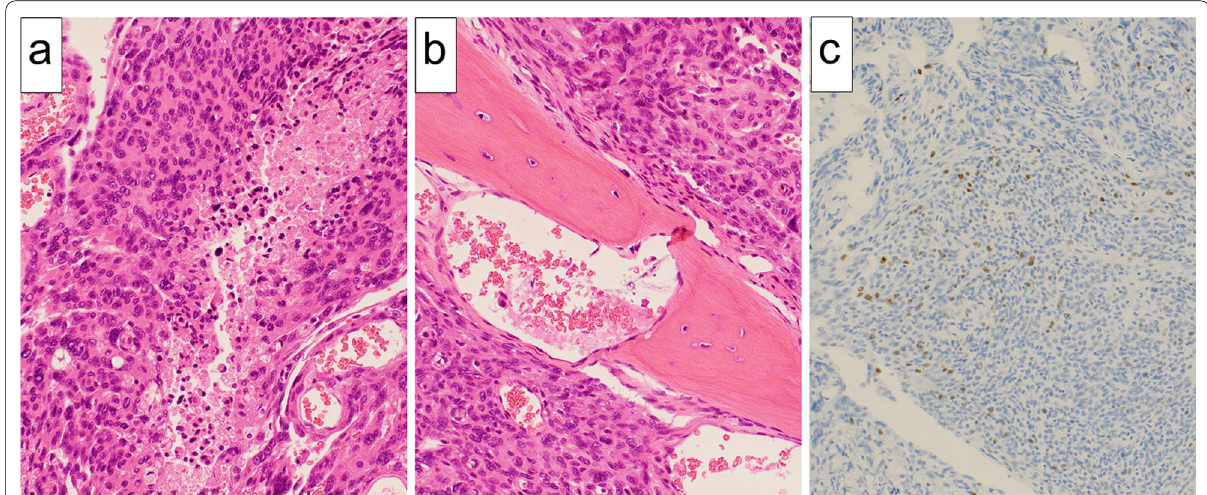
Fig. 2 Pathological findings of the primary intracranial meningioma. a Short spindle-shaped tumor cells with acidophilic cytoplasm were densely proliferated, and the area of necrotic tumor cells were also confirmed (hematoxylin–eosin staining, original magnification 200 observed to infiltrate the bone tissue (hematoxylin–eosin staining, original magnification 200 of tumor cells (immunostaining with anti-MIB-1 protein polyclonal antibody, original magnification 100